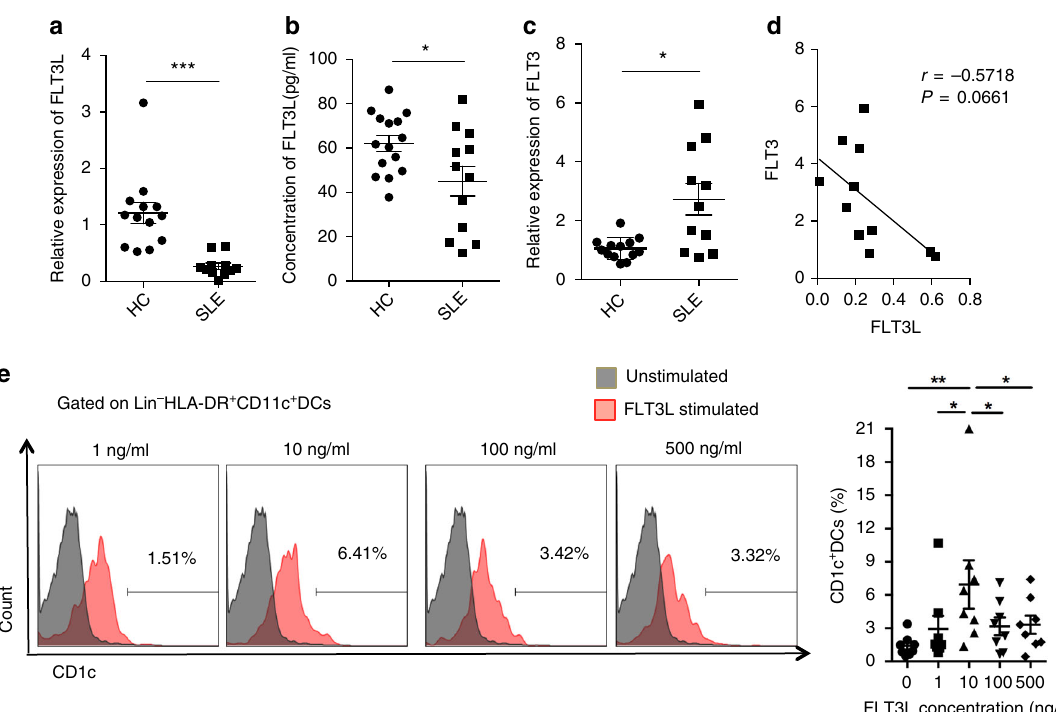
Fig. 2 FLT3L level is decreased in lupus patients. a The mRNA levels of FLT3L in PBMCs from lupus patients ( n = 11) and HC ( n = 13) were analyzed by real- time PCR. b The protein levels of FLT3L in serum from lupus patients ( n = 12) and HC ( n = 15) were analyzed by ELISA. c The mRNA levels of FLT3 in lupus ( n = 11) and HC ( n = 13) PBMCs were analyzed by real-time PCR. d The correlation between the FLT3L and FLT3 in lupus PBMCs was analyzed by Pearson ’ s correlation coef fi cient ( n = 11). e The PBMCs from SLE patients were stimulated with recombinant human FLT3L with 0 ng/ml, 1 ng/ml, 10 ng/ ml, 100 ng/ml, 500 ng/ml, respectively, and after 48 h the percentage of Lin − HLA-DR + CD11c + CD1c + DCs in SLE PBMCs was analyzed by fl ow cytometry ( n = 8). The experiments were repeated ≥ 3 times (* p < 0.05, ** p < 0.01, *** p < 0.001, by t -test or one-way ANOVA), SEM. Source data were provided as a